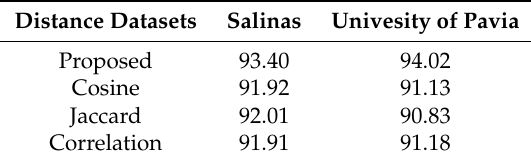
Table 4. Classification evaluation on graph construction with different distance-similarity